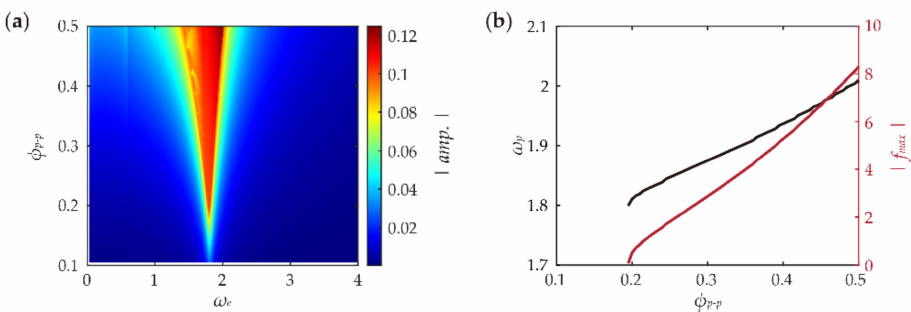
Figure 7. ( a ) Effects of excitation voltage amplitude on the frequency responses of the resonant-impact DEA system and ( b ) effects of excitation voltage amplitude on the peak frequency and peak impact